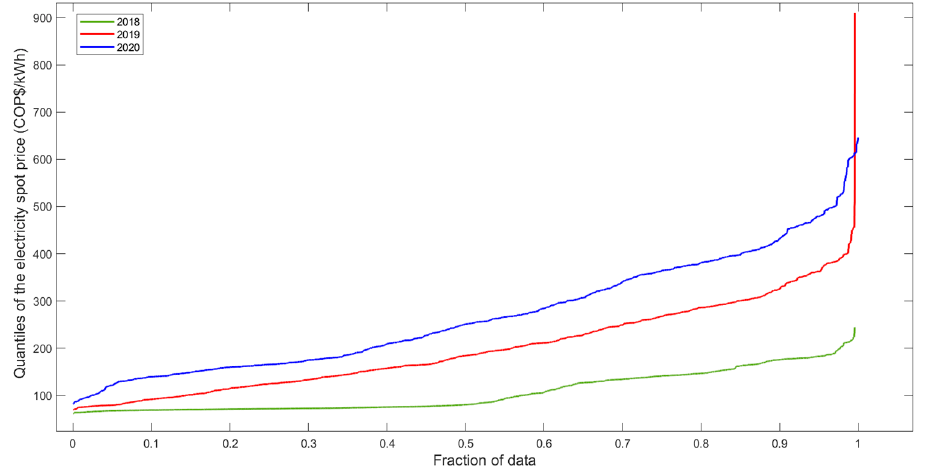
Figure 3. Quantiles’ electricity spot prices for February–September of 2018–2019–2020.